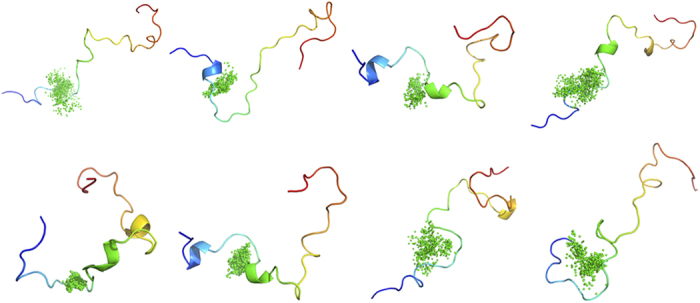
PKUMDL-YC-1205 binds to multiple conformations of c-Myc370–409 in molecular dynamics simulations.Conformations from the five simulations of c-Myc370–409 with PKUMDL-YC-1205 were clustered. The c-Myc370–409 structures are depicted in a rainbow (from blue at the N-terminal to red at the C-terminal) and PKUMDL-YC-1205 structures are depicted at the centres of mass as green dots.